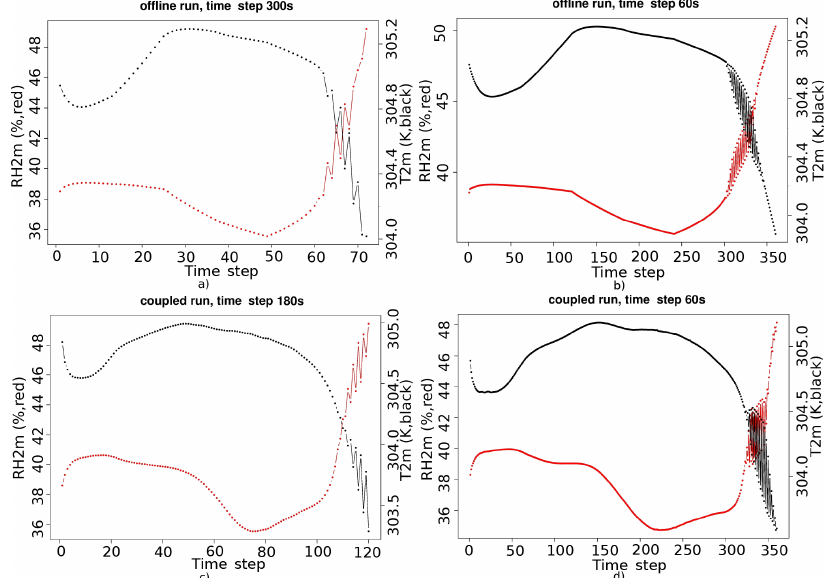
Figure 4. Evolution of T 2m (black) and RH 2m (red) during a 6h SURFEX reference run for 2 July 2010 from 12:00 to 18:00UTC at location A (output plotted every time step). The top left figure shows the results for an offline run with time step 300s, and the top right figure an offline run with a time step of 60s. The bottom left figure shows a coupled run with a time step of 180s and the bottom right figure a coupled run with a time step of